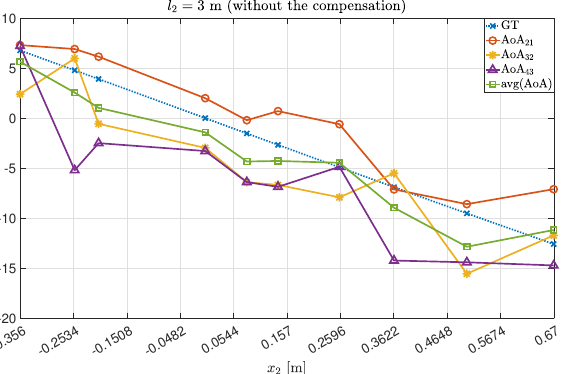
Figure 3. AoA data concerning Exp.#1. In detail, the AoA were computed thanks to the couples {21},{32},{43} and their average.